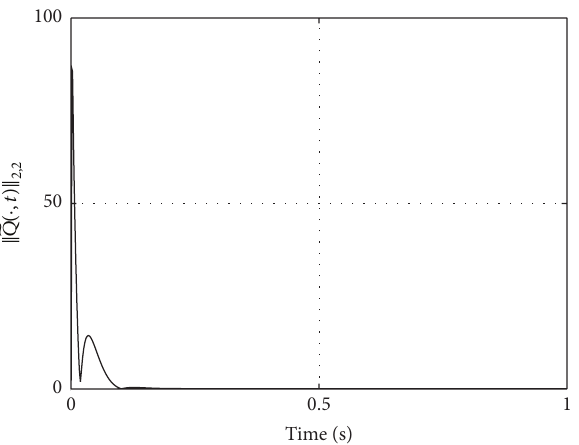
Figure 5: Temporal evolution of the norm